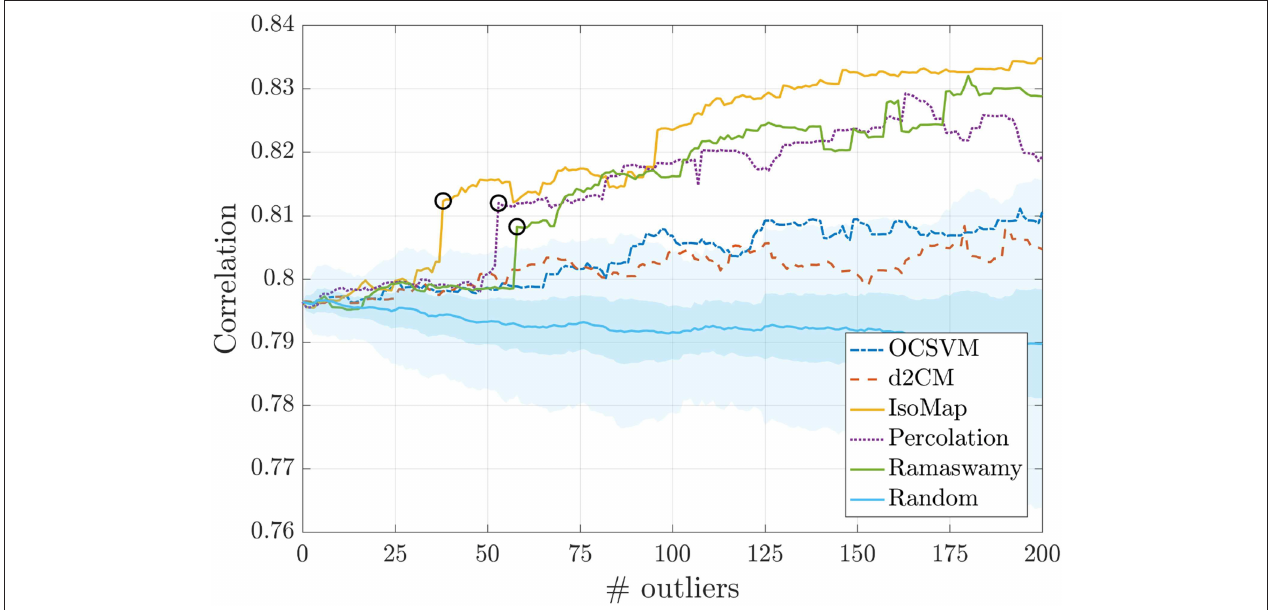
FIGURE 4 | Performance of the OCT image ordering algorithm as a function of the number of outliers that are removed from the database. As expected, we see that the performance, which is measured by the correlation coefficient between the feature returned by the ordering (unsupervised) algorithm and the feature provided by manual expert annotation (mean angle), improves as the outliers detected are removed. The different lines indicate the method of outlier identification and the colored region indicates results when the images removed are randomly selected, one standard deviation is shown in dark coloring, while three standard deviations is shown in light coloring. In this case, as expected, no significant change in the performance is seen. For some methods a sharp improvement is observed when eliminating one specific image (marked with a black circle), this image corresponds to the first one shown in Figure 2